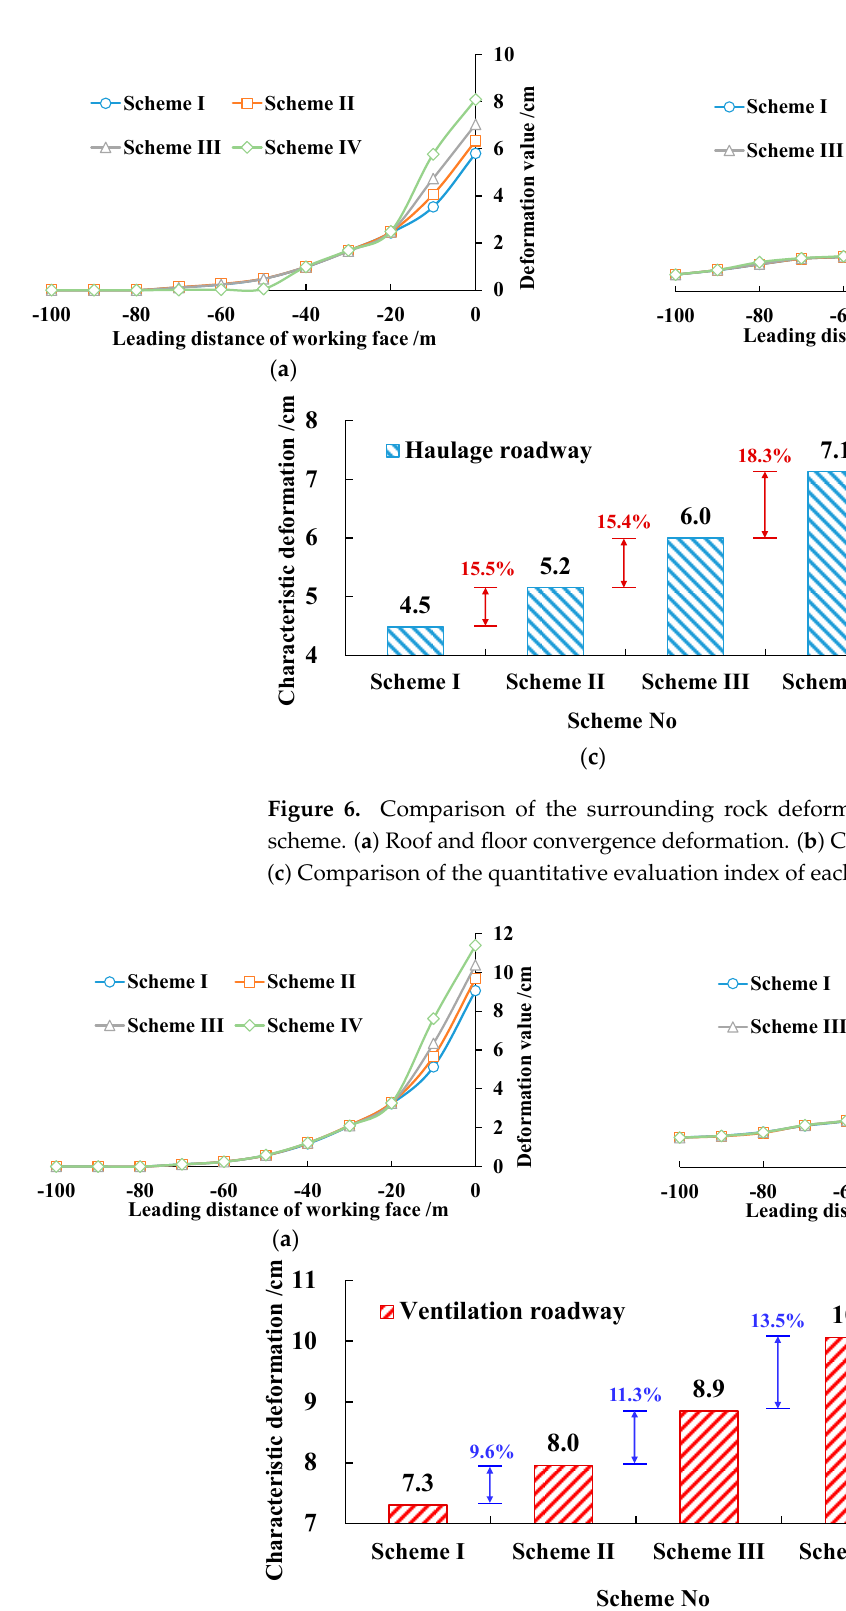
( b ) Figure 5. Comparison curve between the numerical test and field test. ( a ) Deformation of the haul- age roadway. ( b ) Deformation of the ventilation roadway.